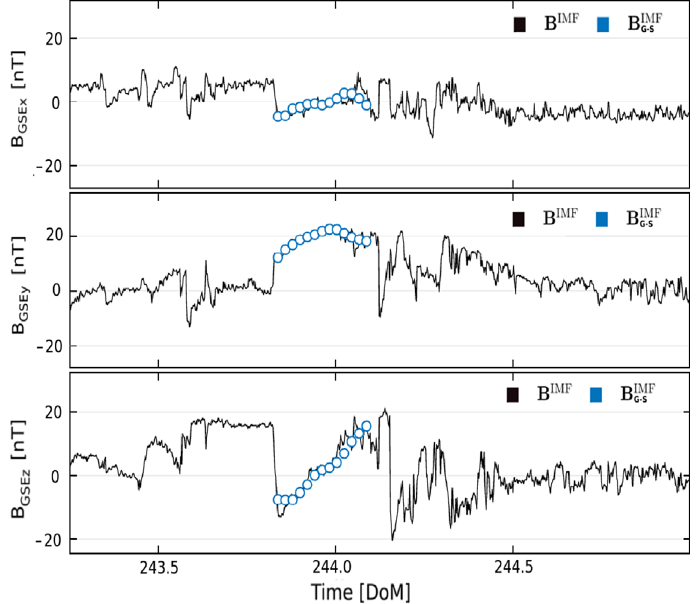
Figure 14. LPF IMF (black line) and IMF along the LPF orbit obtained with a Grad – Shafranov reconstruction based on Wind data of the magnetic cloud crossed by the S/C on August 2 – 3, 2016 (open blue circles). Each LPF IMF component was obtained by averaging the measurements of the four onboard